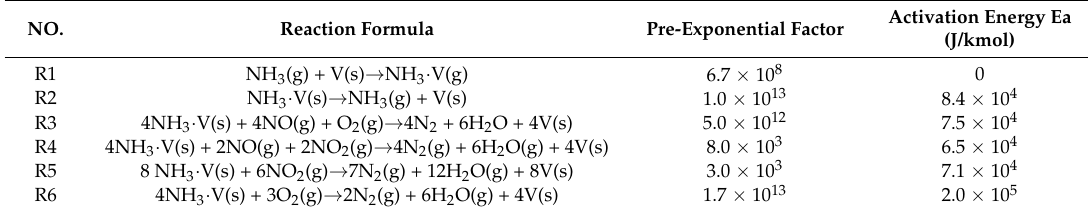
Table 4. SCR reaction pathway and reaction rate.